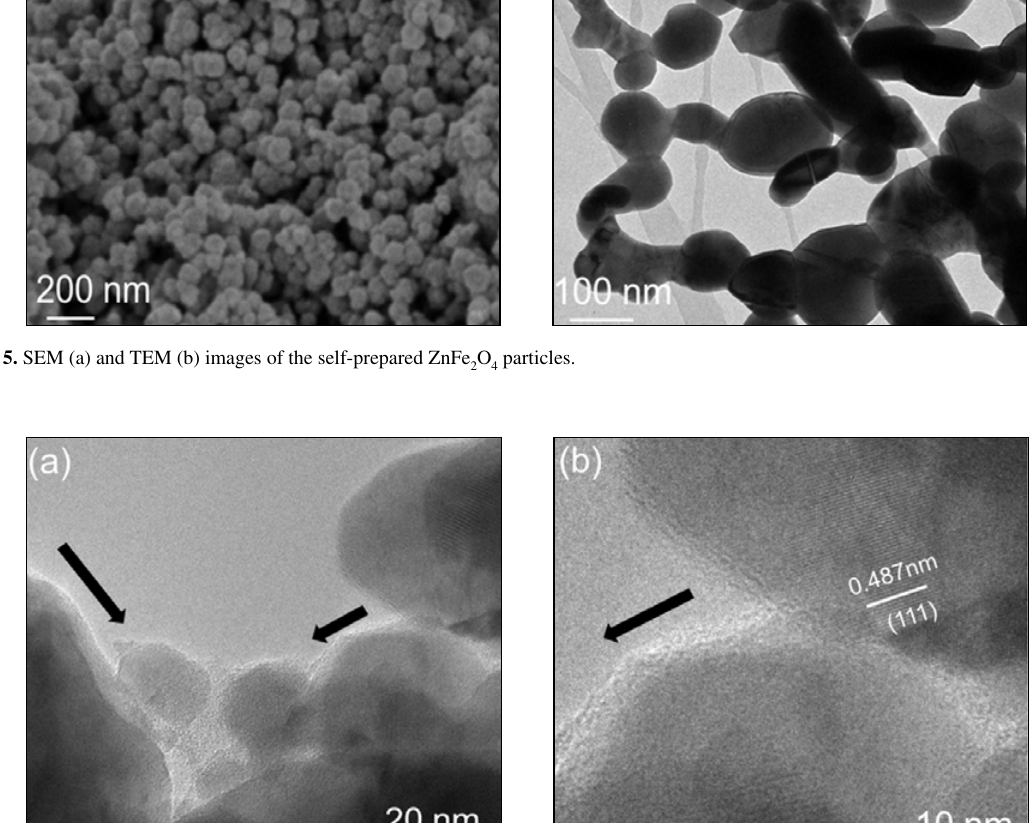
Figure 4. Weight loss curve of the self-prepared ZnFe posite material under oxygen atmosphere.